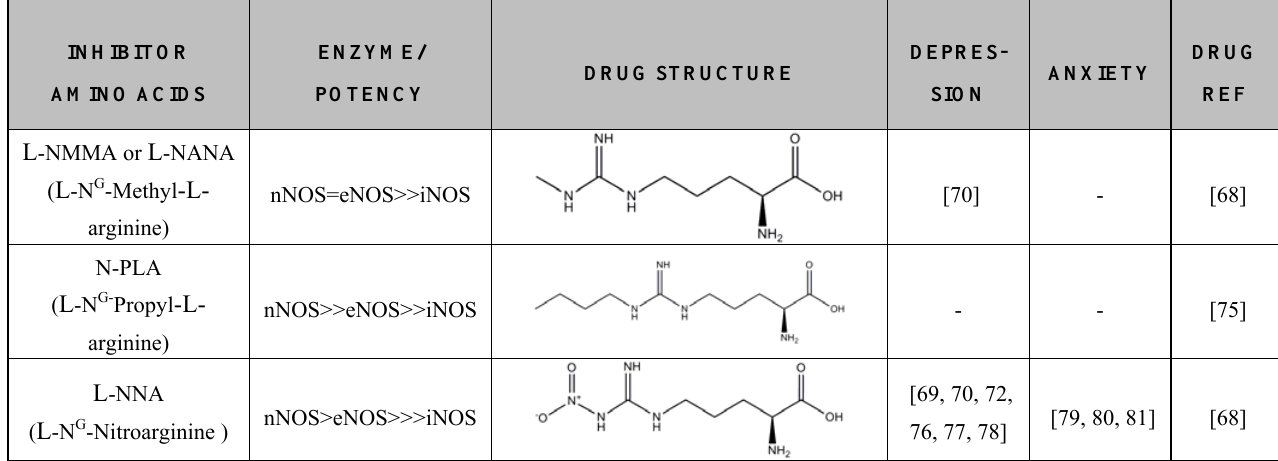
Table 1. NOS inhibitors and studies in paradigms of depression and anxiety based on chemical